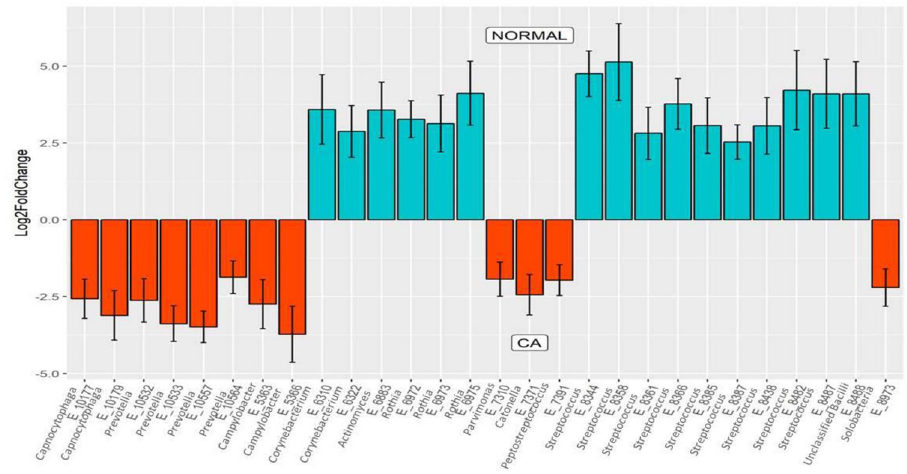
Figure 2. Differentially abundant taxa identified in cancer and normal tissues by DESeq2 analysis. Twenty- eight taxa were differentially abundant between the tumor surface and the tumor tissue.